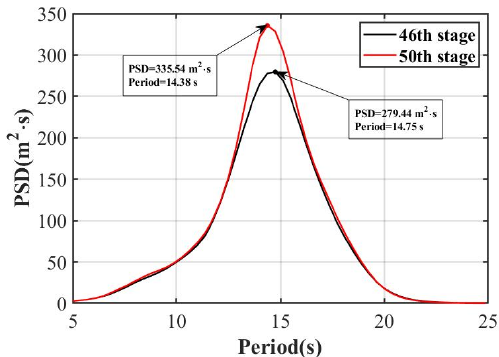
Figure 15. Wave spectra of stages 46 and 50.